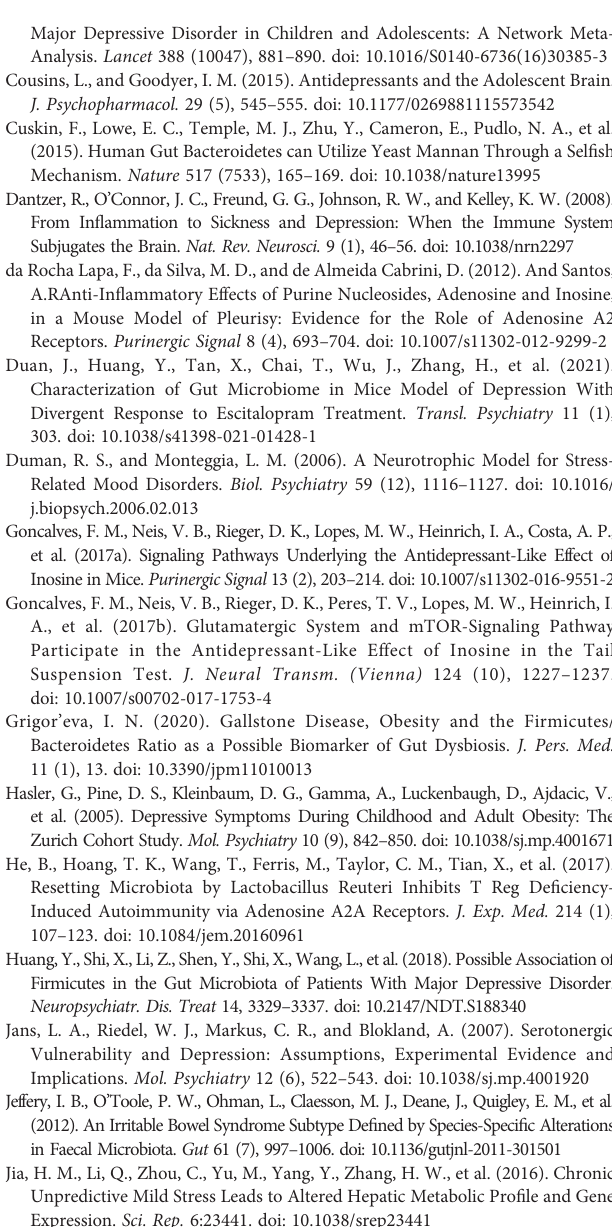
Supplementary Figure S1 | Gut microbial characteristics of adolescent CUMS mice at the a -diversity analysis. (A) The ACE index of a -diversity analysis among three groups. (B) The Chao index of a -diversity analysis among three groups. (C) The Shannon index of a -diversity analysis among three groups. (D) The Simpson index of a -diversity analysis among three groups. Supplementary Figure S2 | The results of body weight and sucrose preference from baseline to endpoint. (A) The body weight. (B) The sucrose